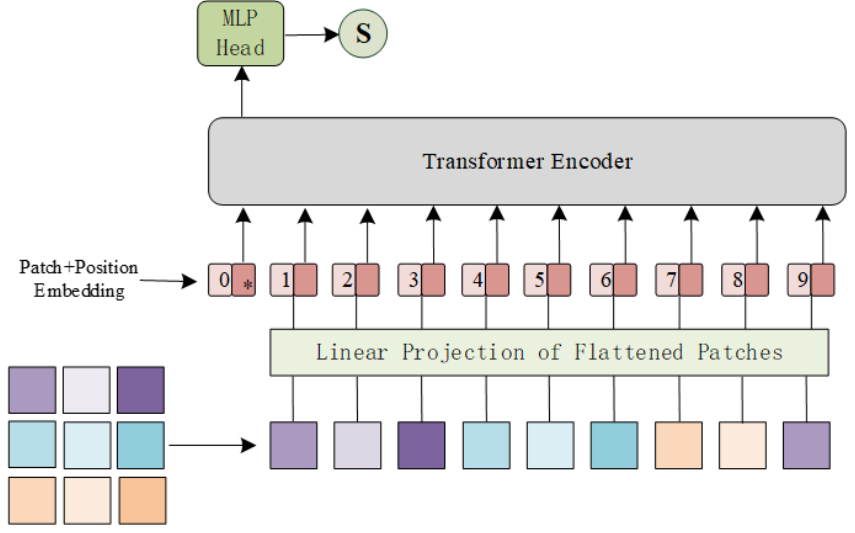
Figure 4. The detailed structure of the transformer discriminator used in this article. In addition, the ‘*’ symbol represents class token.